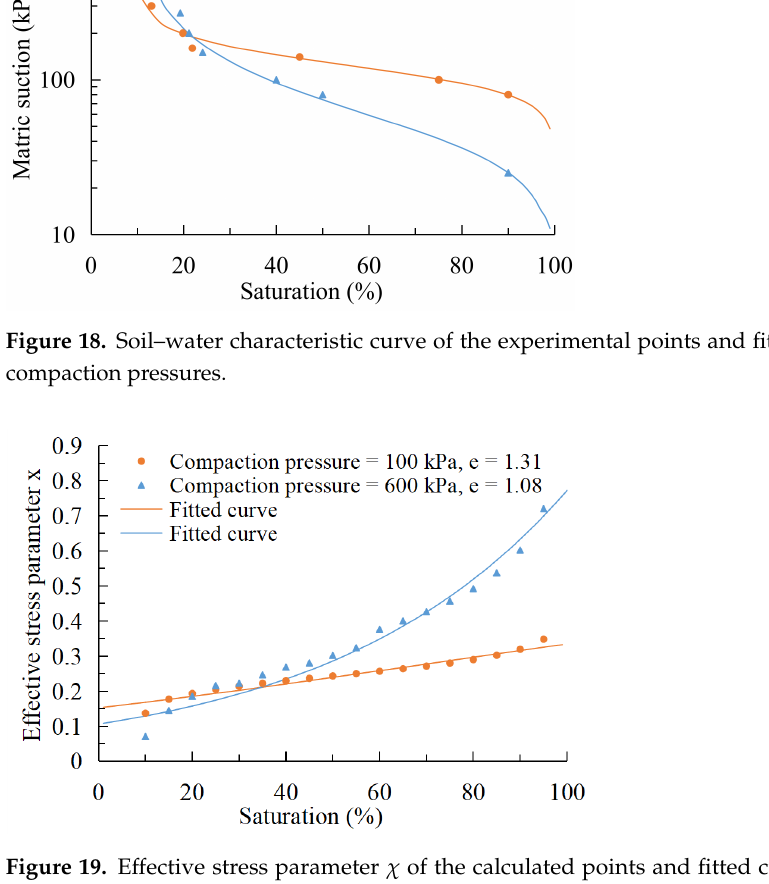
of the calculated points and fitted curve at different com- 𝜒𝜒